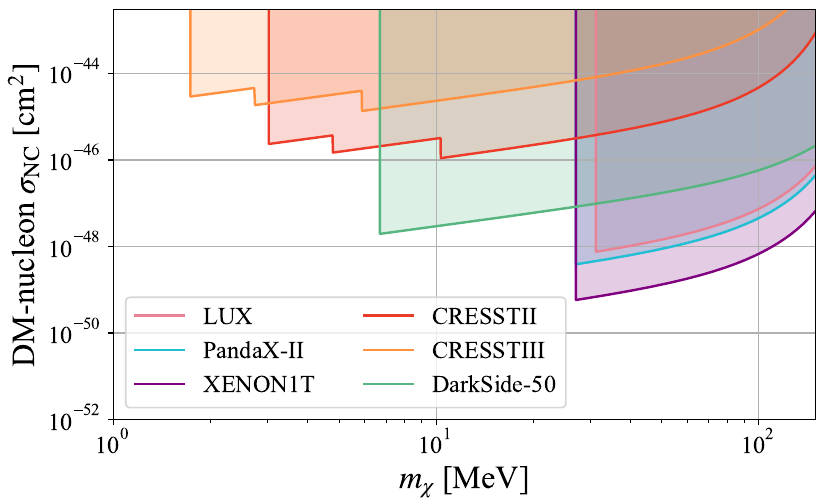
Figure 2 . Projected constraints on the DM-nucleon cross section σ NC in our model as a func- tion of m χ . The constraints are given for different experiments: LUX (pink) [25], PandaX-II (blue) [26], XENON1T (purple) [27], CRESSTII (red) [28], CRESSTIII (orange) [29] and DarkSide- 50 (green) [30, 31]. The target isotopes include 131 Xe for LUX, PandaX-II, and XENON1T, 186 W , 40 Ca , 16 O for CRESSTII and CRESSTIII, and 40 Ar for